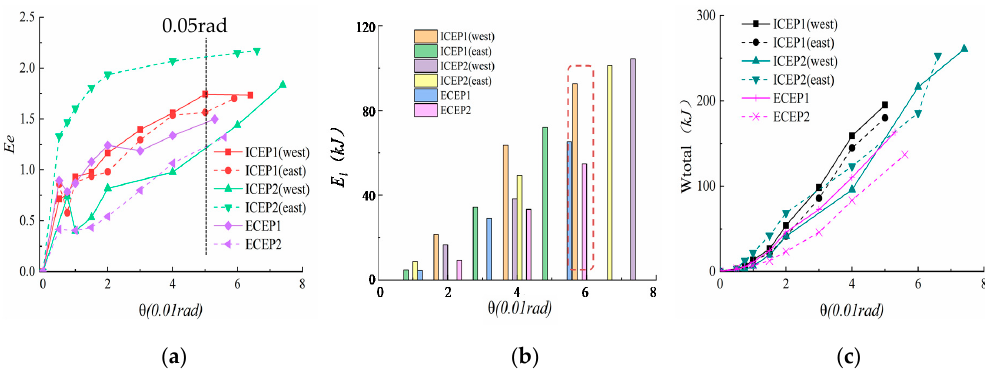
Figure 14. Energy dissipation: ( a ) Equivalent viscous damping; ( b ) Energy dissipated during in each step; ( c ) Accumulated energy dissipation.